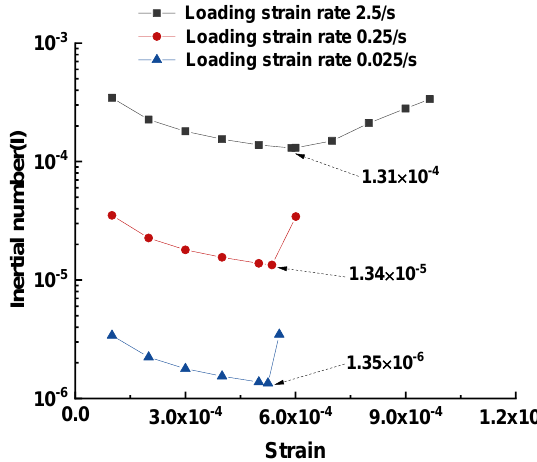
Figure 9. Inertial number with respect to axial strain at varying loading rates ranging from 0.025 s − 1 to 2.5 s − 1